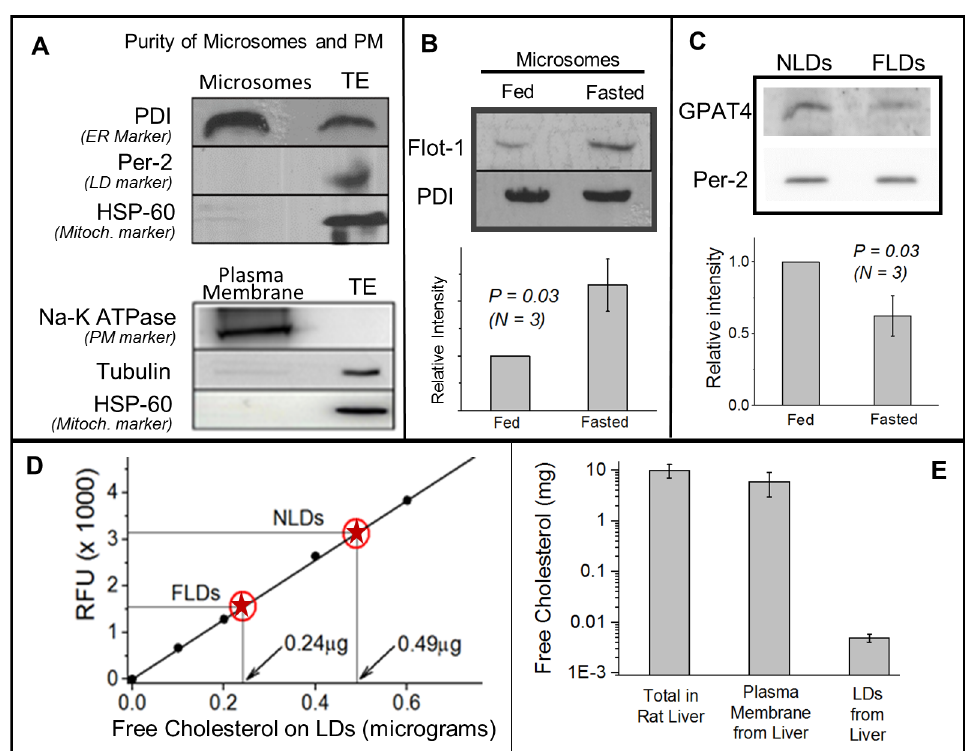
Fig 2. Feeding-fasting dependent changes in flotillin-1, GPAT4 and free cholesterol (FC) on LDs and ER-enriched microsomes. (A) Upper panel The microsome fraction isolatedfrom normally fed rat liver is enriched in PDI (ER marker). Mitochondrial marker (HSP-60) and LD marker (perilipin-2) are not detected on the microsomes. Liver tissue extract (TE) with equal amount of protein as microsomes was loaded.Lower panel A membranefraction isolated from normally fed liver is enrichedin the plasma membranemarker (Na-K ATPase). No cytosolic or mitochondrial contamination is detected. (B) Flotillin-1levels increaseon the microsome fraction in fasted liver as comparedto fed state. Western blottingagainst PDI (ER marker) shows equal loadingof the ER samples.This experiment was repeatedwith consistent results on three pairs of fed and fasted animals. Error bars are SEM. (C) GPAT4 localisation on LDs decreases after fasting. Western blotting using anti-GPAT4 antibody shows higher level on NLDs as comparedto FLDs. Equal amount of NLD and FLD samples was loaded, as determined from equal intensity of perilipin-2 band on these samples. This experiment was repeatedon three pairs of fed and fasted animals, yieldingsimilar results. Error bars are SEM. (D) Measurement of free cholesterol (FC) by a fluorimetric method. Y-axis denotes relativefluorescence units (RFU). Knownamounts of cholesterol standards (filled circles) were used to build a calibration curve (straight line). The RFU value was then measuredfor NLDs and FLDs (red circles with star). The corresponding amount of FC in these samples was then read off from the calibrationcurve (shown in graph). This measurement shows two-fold more FC in NLDs as comparedto FLDs. Equal NLD and FLD samples were loaded,as determined from equal TG amounts in the samples in TLC experiments. Duplicatesof all the sampleswere used for the assay. This experiment was repeatedtwice with similar results (using two pairs of animals).(E) Estimation of free cholesterol in wholerat liver tissue extract, plasma membranes from rat liver, and LDs purifiedfrom rat liver. Liver of normally fed rats were used. Note the logarithmicscale on Y axis. Crude liver tissue extract sample was preparedfrom a known mass of liver tissue, and a TLC experiment was run with this sample, along with known dilutionsof FC as standards(not shown). The best match was used to estimate total amount of FC in the liver extract sample ( N = 3). Similarly, PM and LDs were preparedand comparisonwas done with FC standards in a TLC experiment. The total FC on PM and LDs was then estimated for the wholeliver (see methods).